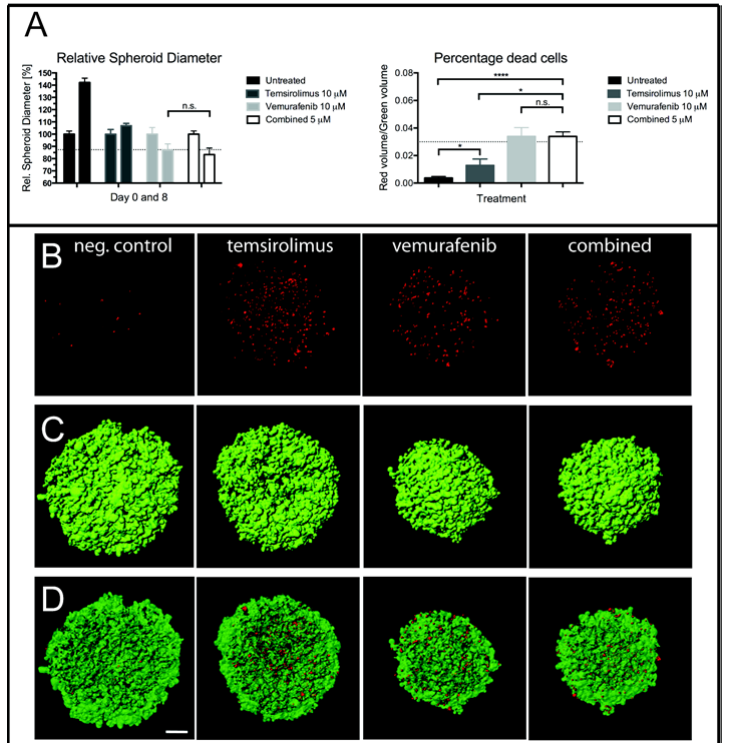
Figure 3. Multicellular spheroid growth of H1_DL2 cells after treatment with vemurafenib and temsirolimus. ( A , left) Spheroid diameters measured zero and eight days after treatment with 10 µ M of temsirolimus, 10 µ M of vemurafenib or the combined treatment (5 µ M temsirolimus + 5 µ M vemurafenib) ( n = 6, mean ± SD). n.s.: not significant; * p < 0.05, **** p < 0.0001. ( A , right) The percentage of dead cells within the spheroids after treatment for three days with 10 µ M of temsirolimus, 10 µ M of vemurafenib or the combined treatment (5 µ M temsirolimus + 5 µ M vemurafenib); ( B ) Maximum intensity projection images of the red channel (dead cells) of confocal image stacks of spheroids treated with 10 µ M of temsirolimus, 10 µ M of vemurafenib or the combined treatment (5 µ M temsirolimus + 5 µ M vemurafenib); ( C ) The surface volume of the green channel (live cells) of the same spheroids as in ( B ); and ( D ) An overlay of the red and green volume surfaces of the same spheroids as in ( B ). Scale bar = 100 µ m. neg. control = negative